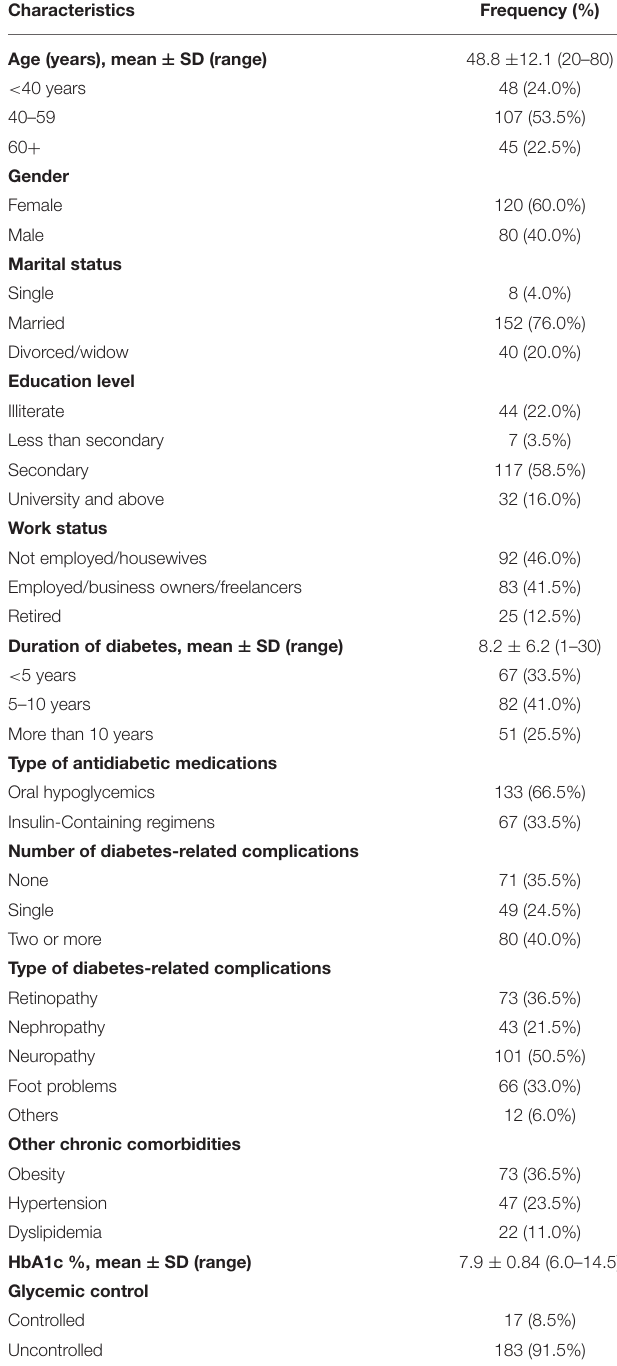
TABLE 1 | Patients’ demographic and clinical characteristics ( N = 200).